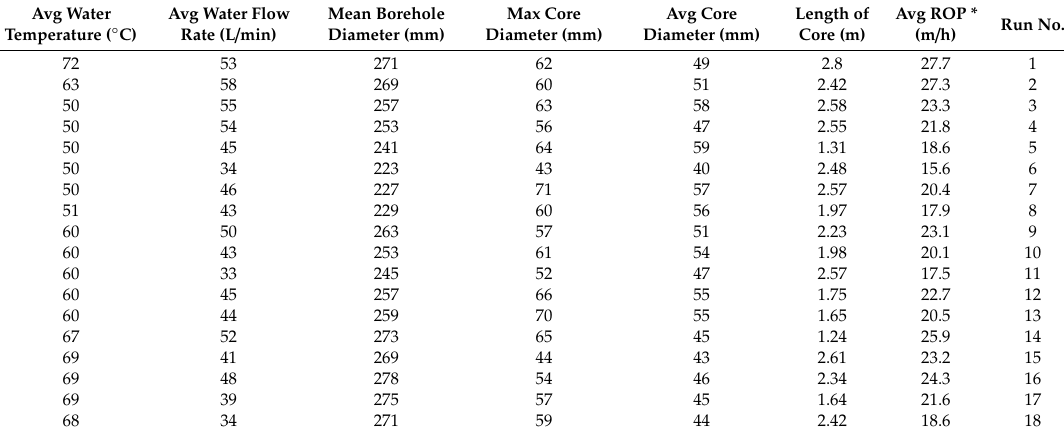
Table 1. Main results of the hot water ice-coring drill tests.